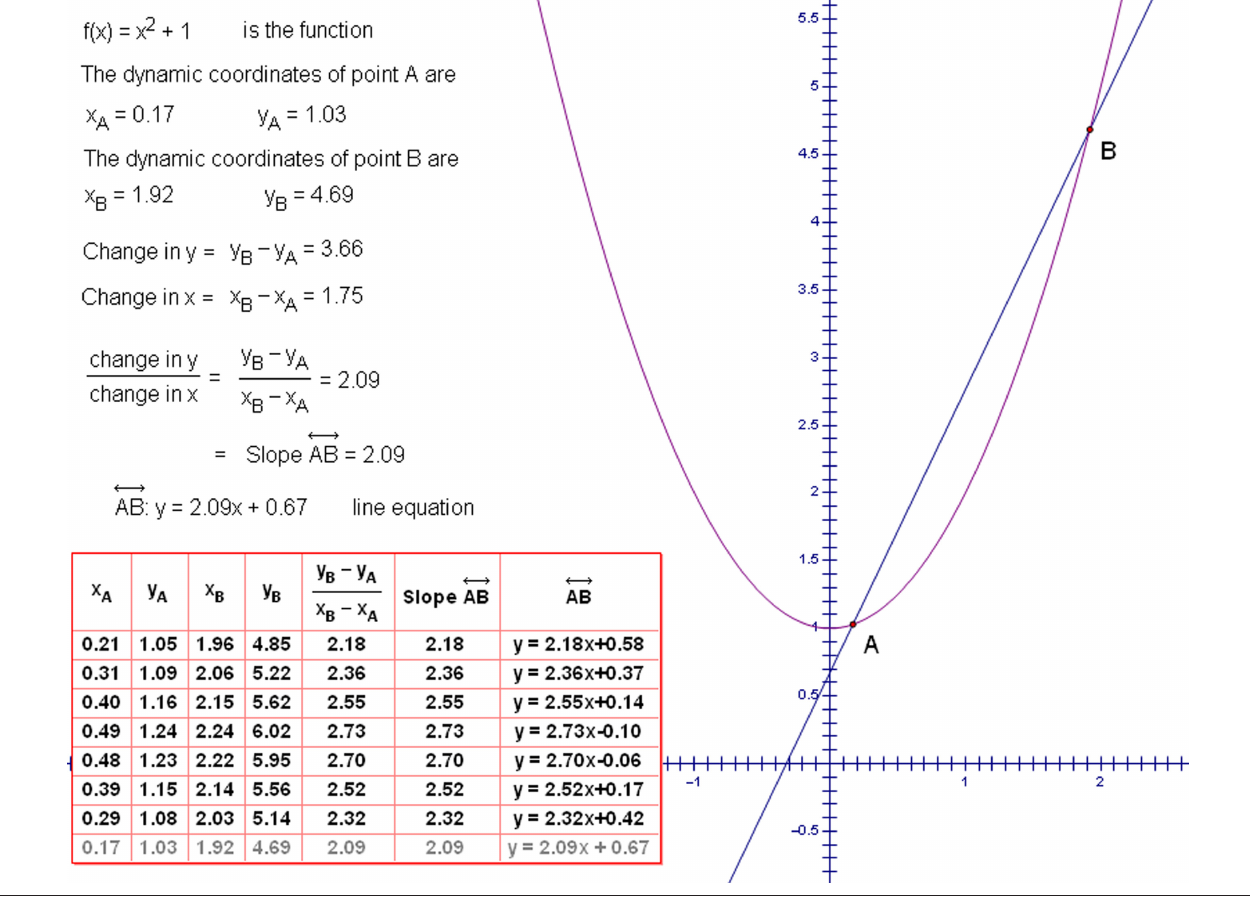
FIGURE 2: Graph of f ( x ) = x 2 + 1 and the secant line AB (modelling the average rate of